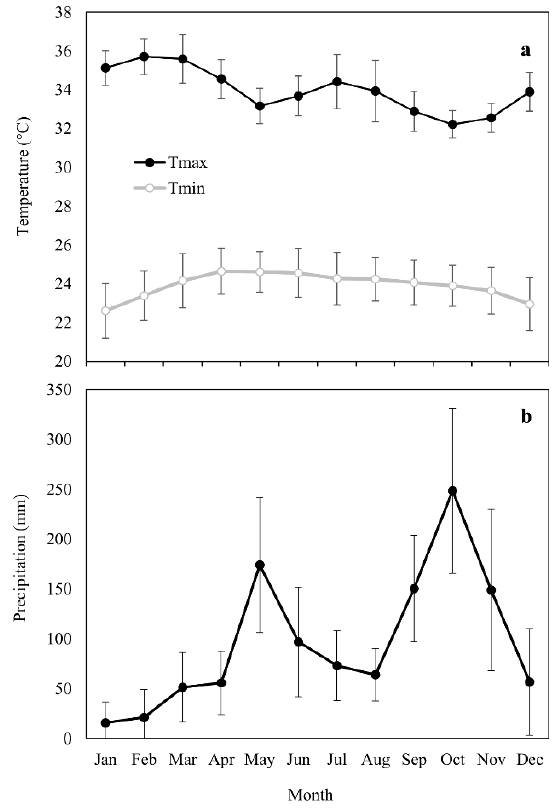
Figure 1. Long-term (1980–2019) mean monthly ( a ) maximum (Tmax) and minimum (Tmin) temperatures and ( b ) precipitation amounts in the Motilonia Research Center of Agrosavia (Cesar, Colombia). Error bars represent standard deviation.